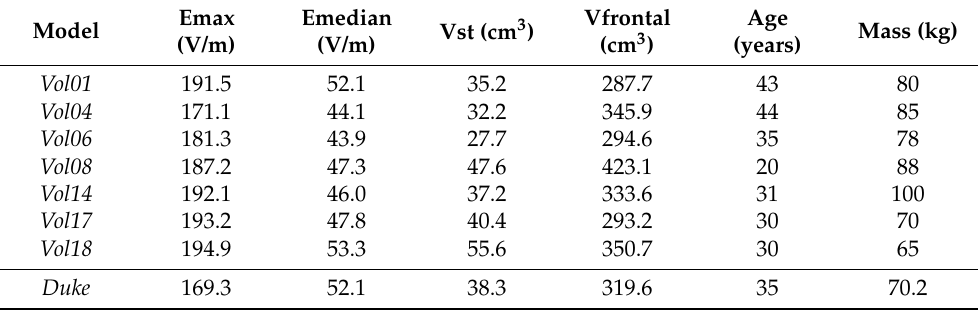
Table A1. Stimulation metrics (Emax, Emedian, and Vst) on the frontal lobe and model parameters (frontal lobe volume, age, mass) of the anatomical male models and the Duke ViP model.